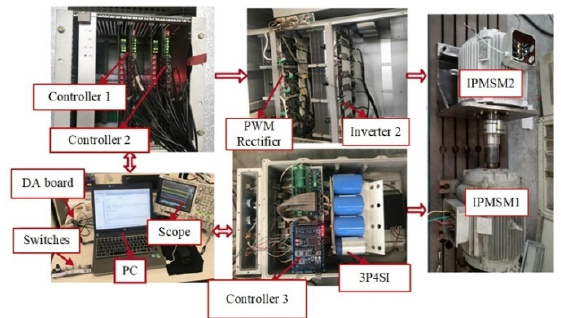
ψ Figure 8. Control diagram of the switching sequence MPDTC. 4. Experimental Results and Discussion 4.1. Experimental Prototype To validate the effectiveness of the proposed switching sequence MPDTC of IPMSM for EV in switch-open fault-tolerant mode, an experimental setup as shown in Figure 9 was established. A 320 V dc-link voltage is obtained by the PWM rectifier controlled by the controller 1 to simulate the lithium battery packs. IPMSM1 and IPMSM2 are coaxially connected. IPMSM1 is connected with the 3P4SI, and the proposed control strategy is implemented by the controller 3. IPMSM2 is the load motor, which is fed by the inverter 2 with controller 2. The main parameters of the 3P4SI and IPMSM1 are given in Table 1. Table 1. Parameters of the IPMSM. Parameter